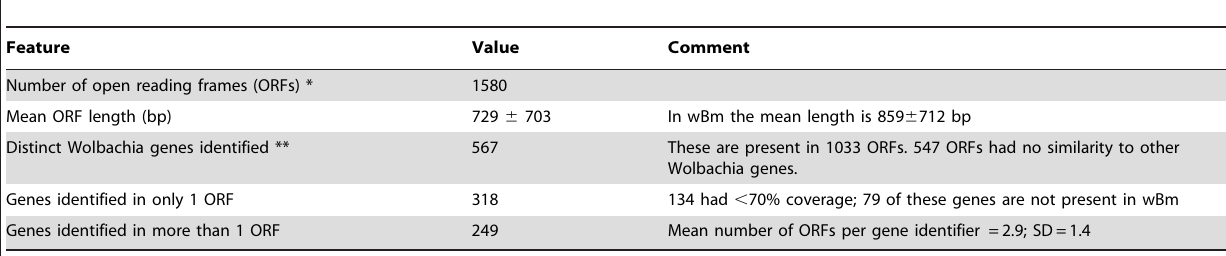
Table 3. Putative Wolbachia -like open reading frames identified in the Dictyocaulus viviparus nuclear genome.